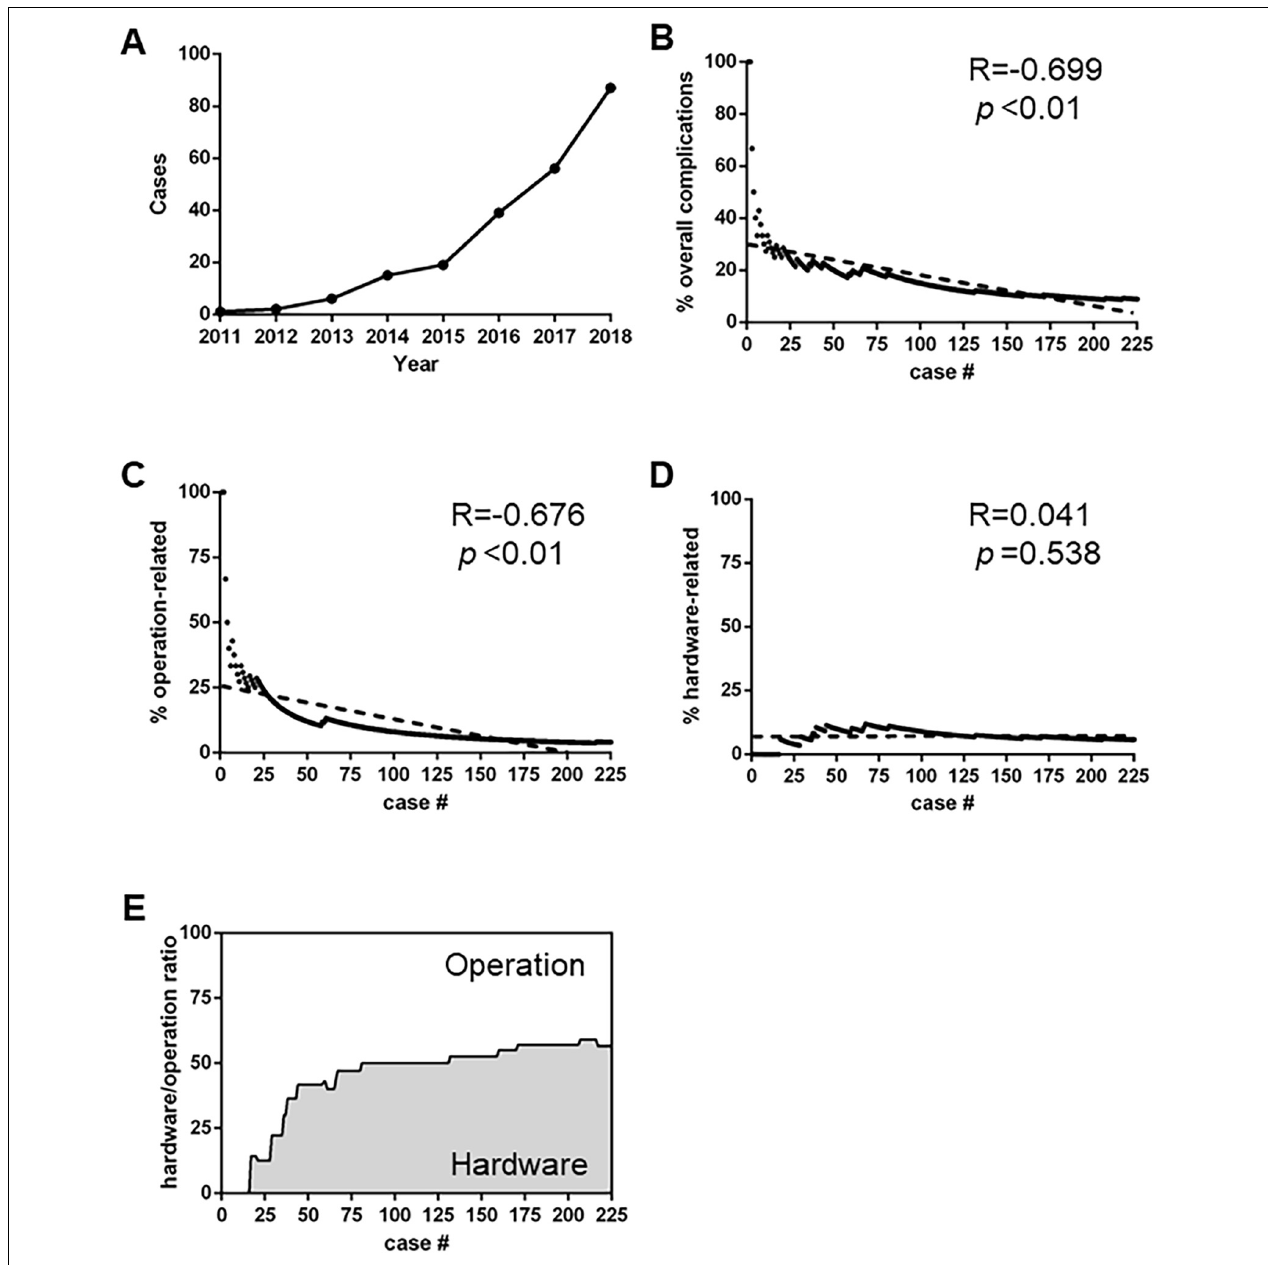
FIGURE 3 | Secular trend of postoperative complications. (A) : The annual number of DBS surgical procedures in our center. (B) The incidence of overall complications with increased number of Deep brain stimulation (DBS) volumes ( R = –0.699, p < 0.01) (C,D) Different trends of operation-related (C) and hardware-related (D) complications ( R = –0.676, p < 0.01 and R = 0.041, p = 0.538, respectively). (E) The ratio of hardware-related complications versus operation-related